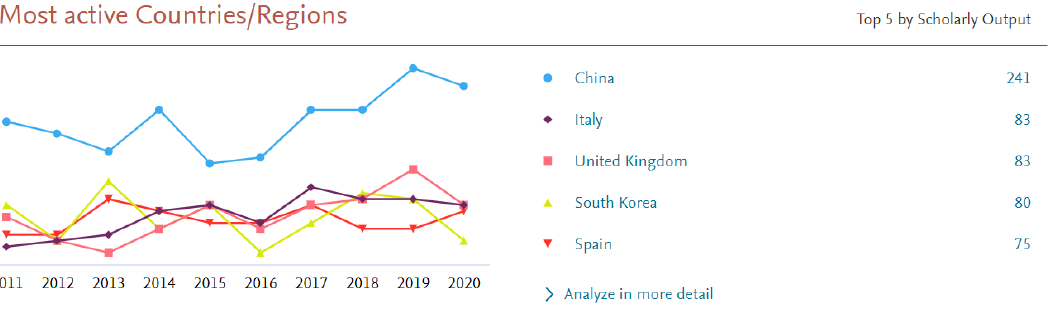
Figure 4. Most active institutions for the topic «T.18162 Facades; Blinds; Natural Ventilation». The most active Countries/Regions for the topic «T.18162 Facades; Blinds; Natural Ventilation» are shown at Figure 5.